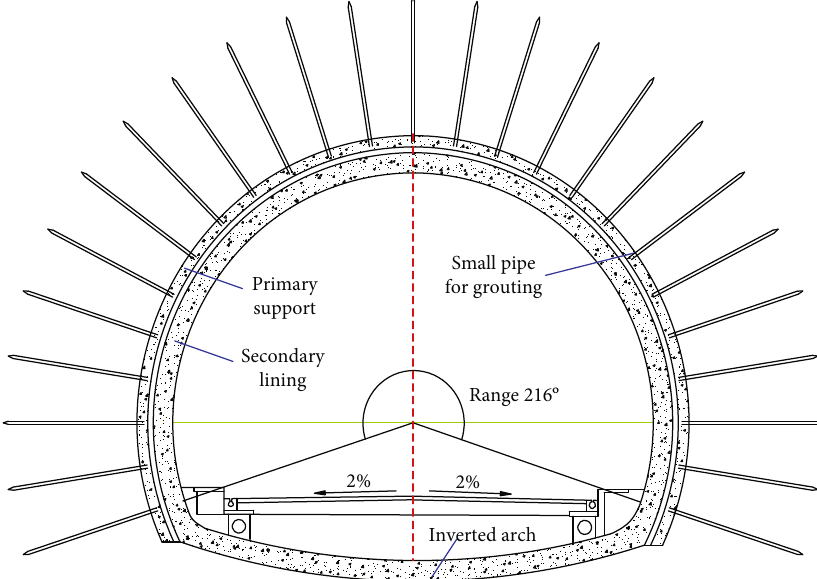
Figure 11: Diagram of tunnel support